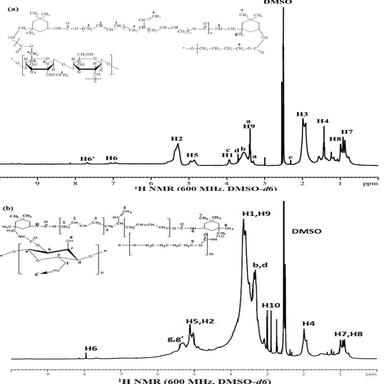
1 H NMR of (a) pristine starch based PU and (b) pristine chitosan based PU.